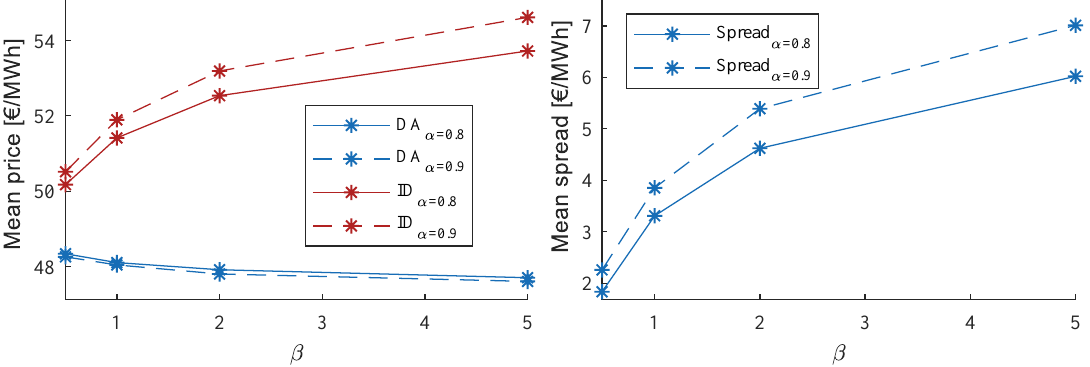
Figure 10. Impact of α and β on the mean market price ( left ) and the mean spread between ID and DA ( right ). in the German market